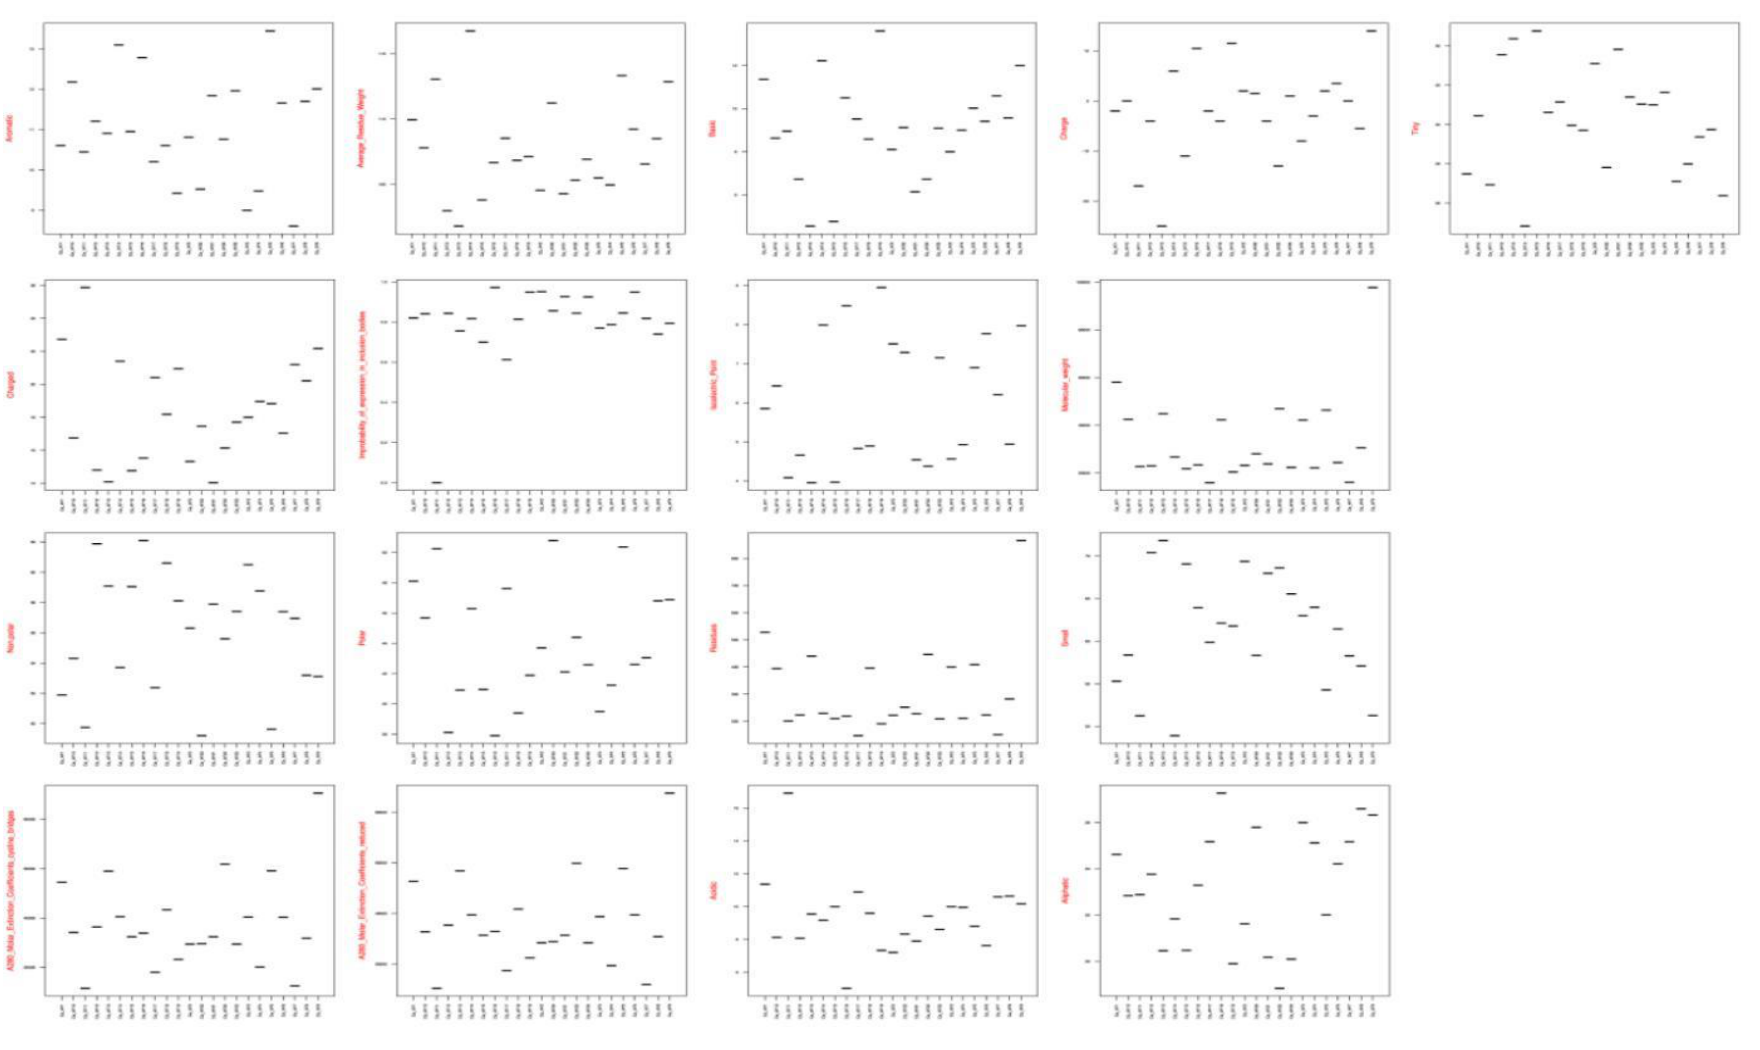
Figure 2 : The chemical and physical properties of identified anti-fungal proteins in